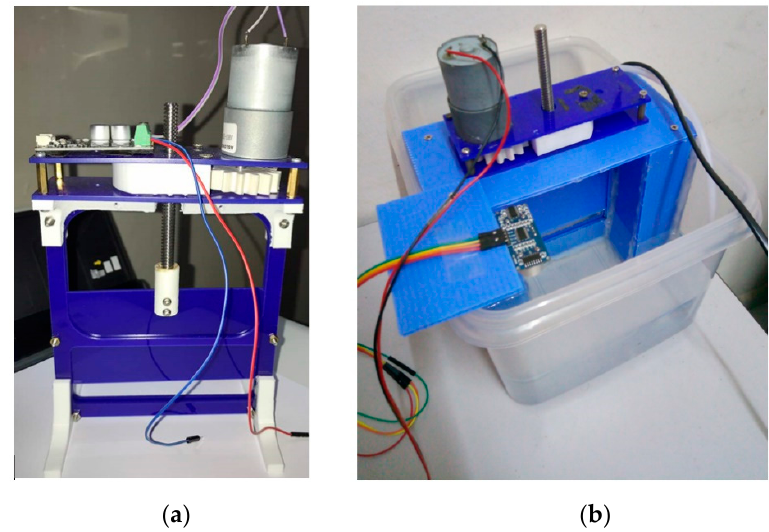
Figure 2. Actual model of gate: ( a ) at first stage vs. ( b ) the modified model, Gate V1.